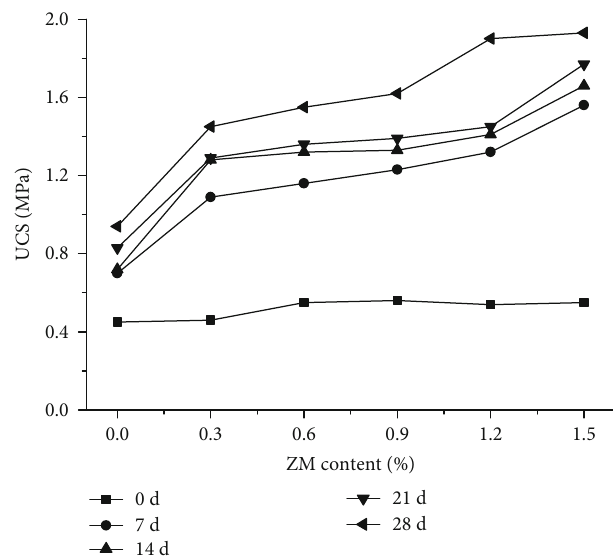
Figure 3: E ff ect of the ZM concentration on the UCS for di ff erent curing